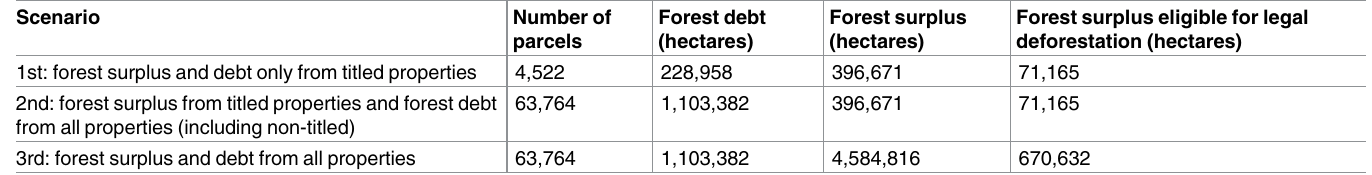
Table 3. Description of forest debt, forest surplus and areaseligible for legal deforestation in three scenarios.